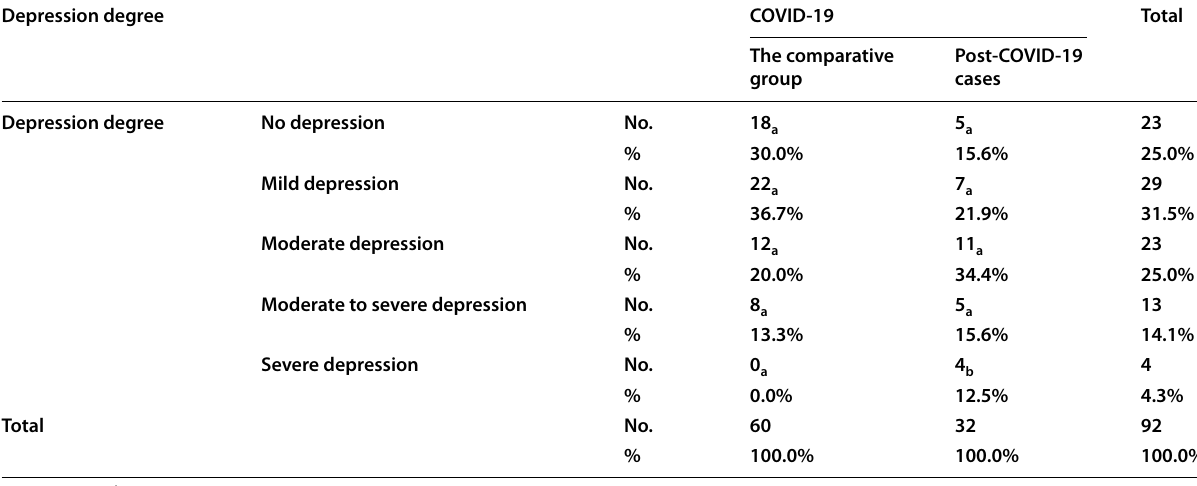
Exact Pearson chi-square